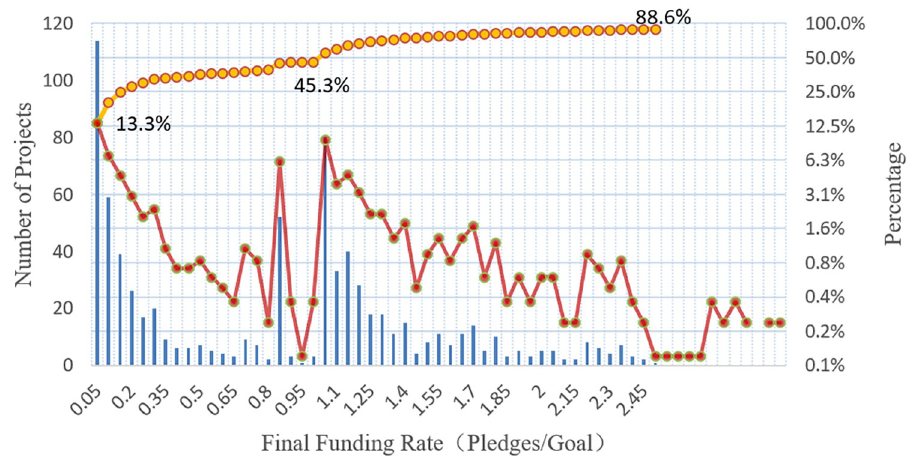
Fig 2. Distribution of project funding rate (logarithmic